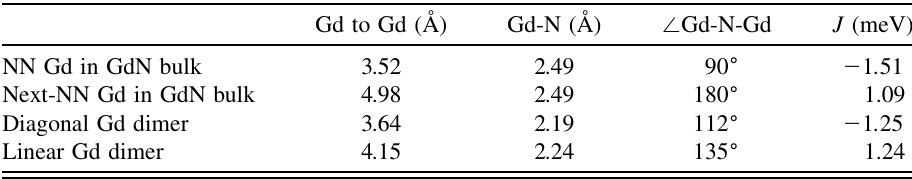
TABLE I. Gd-to-Gd distances, Gd-N bond length, Gd-N-Gd bond angle, and the spin coupling J between Gd, calculated for four systems. The Gd dimers are placed on the CuN surface. Gd to Gd (A˚ )